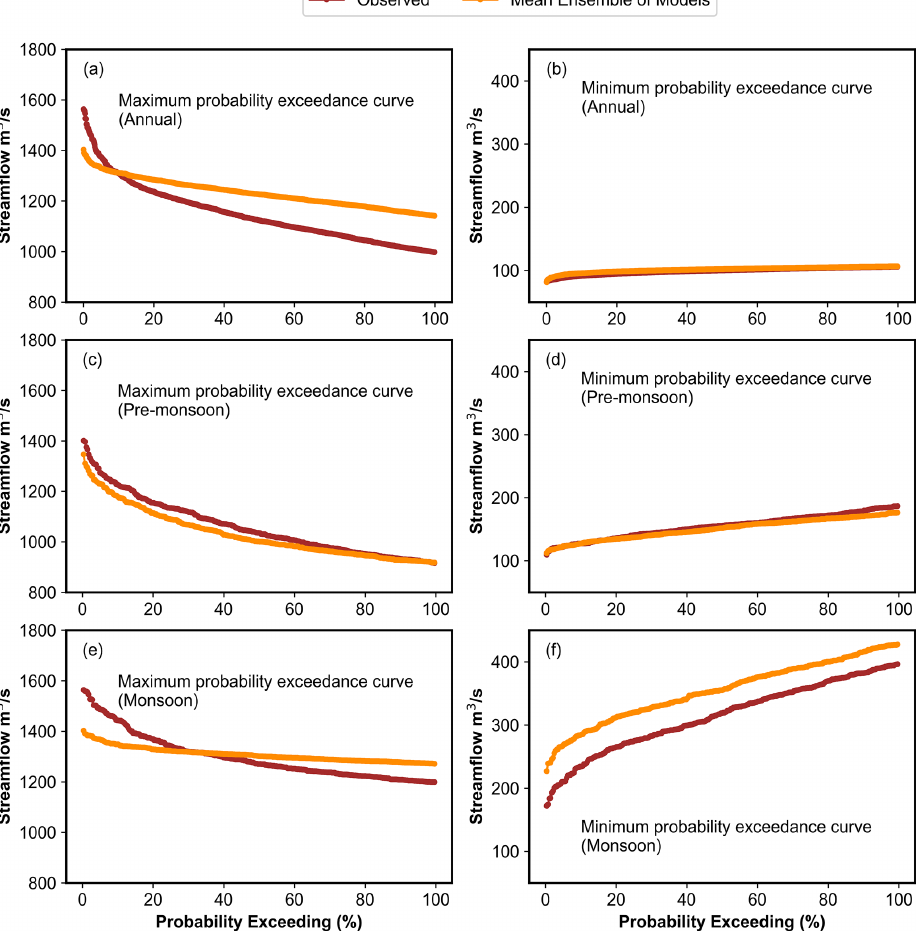
Figure 10. Probability exceedance curves developed using 10% of the highest and lowest flows from the observed and CMIP6-GCM- simulated (mean ensemble of models) flows over the time span of 1979–2009 for annual and seasonal (pre-monsoon and monsoon)